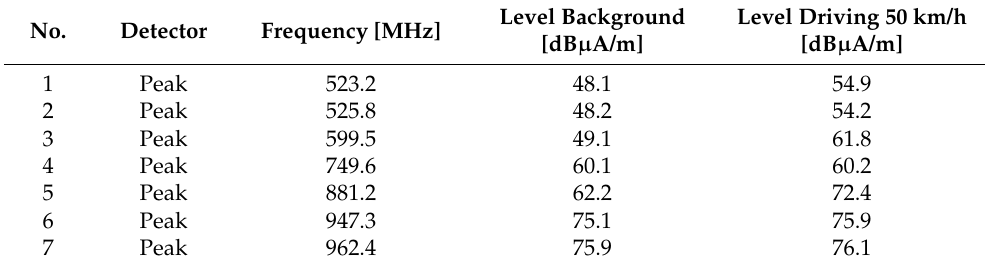
Table 7. Measurement method and results obtained for individual frequencies, for a rail vehicle travelling at a speed of 50 km/h and the electromagnetic